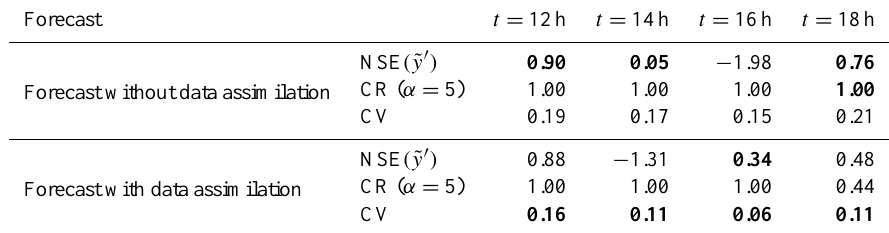
Table 5. Results of the validation measures for the February 2004 flood event. Forecast